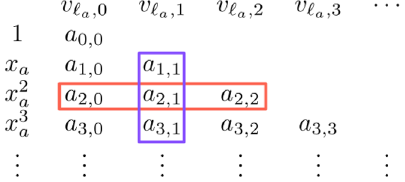
Figure 10 . We organize the information that each state contributes to the determination of a k,q . For each fixed row (fixed k ), for example the red box, each state’s contribution is proportional to a Gegenbauer vector multiplied by a universal factor x k box, each state contributes to a point on a half moment curve multiplied by universal factor v